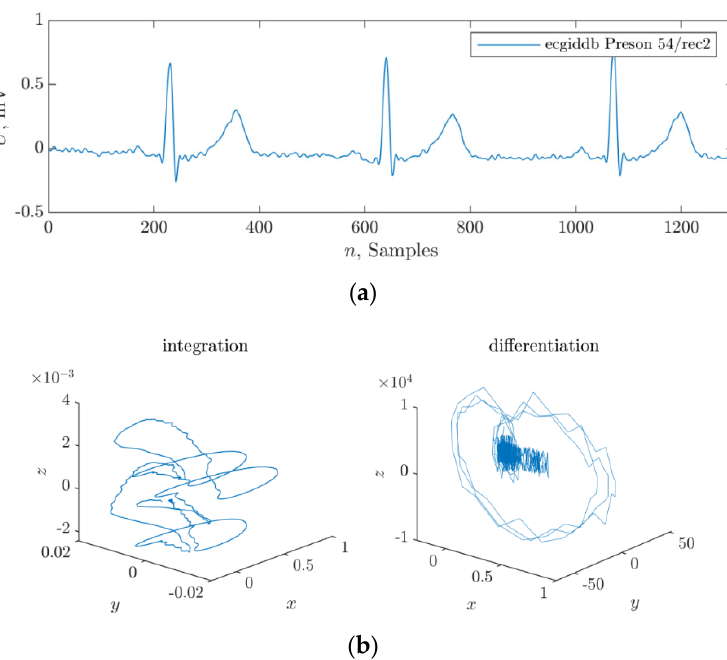
Figure 4. Example of the phase space reconstruction. ( a ) ECG time series x ; ( b ) comparison of the integration-based approach (left) and the differentiation-based approach (right).